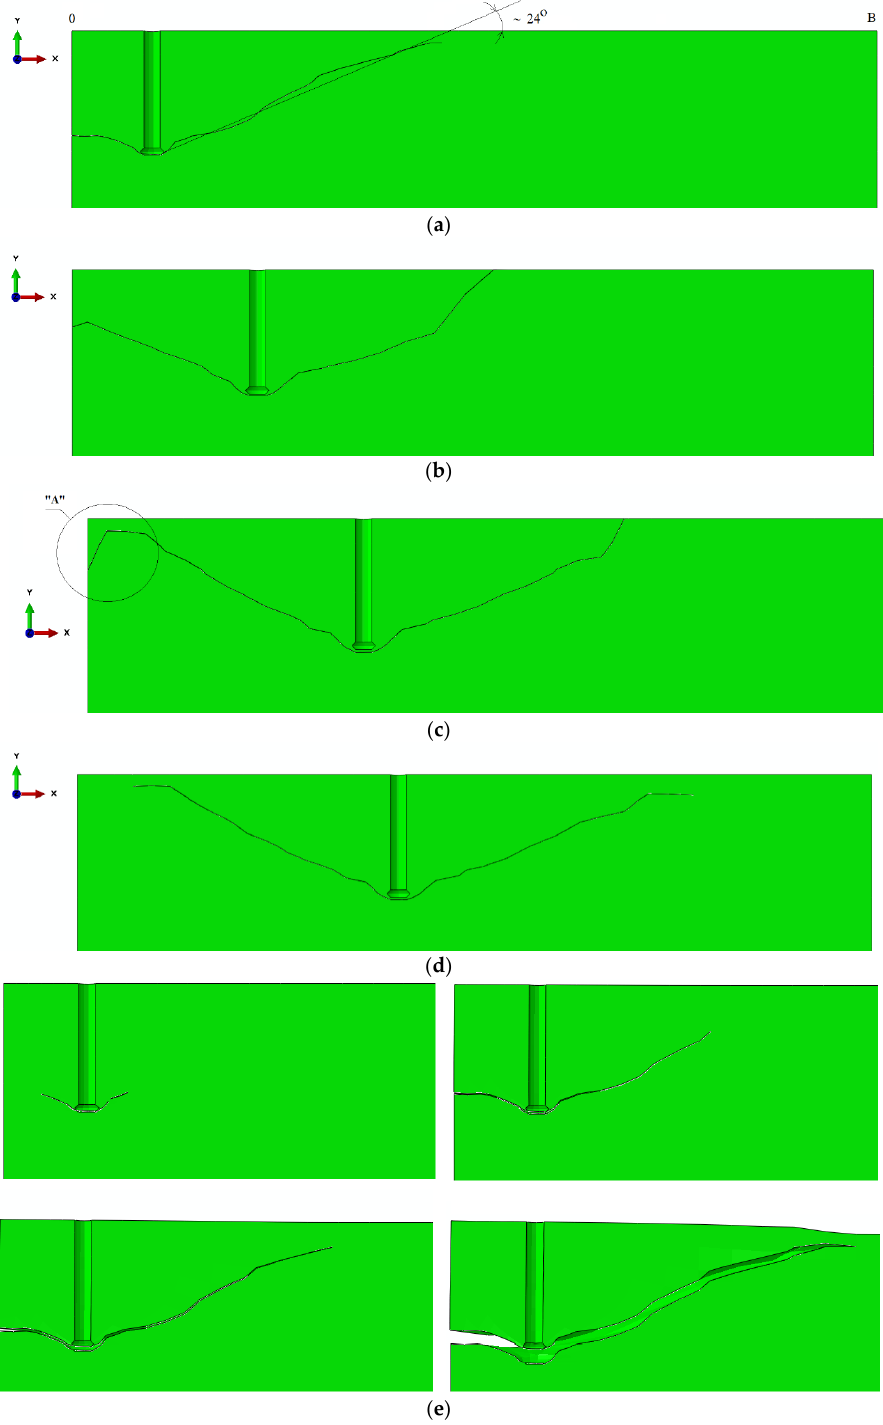
Figure10. Crackpropagationandbreak-outconeangle a ,for r i : ( a )115.47mm, ( b ) 230.94 mm, ( c ) 346.41 mm, ( d ) 404.14 mm. Detail “A”—“wandering” of the gap, ( e ) crack propagation for the anchor system for r i : 115.47